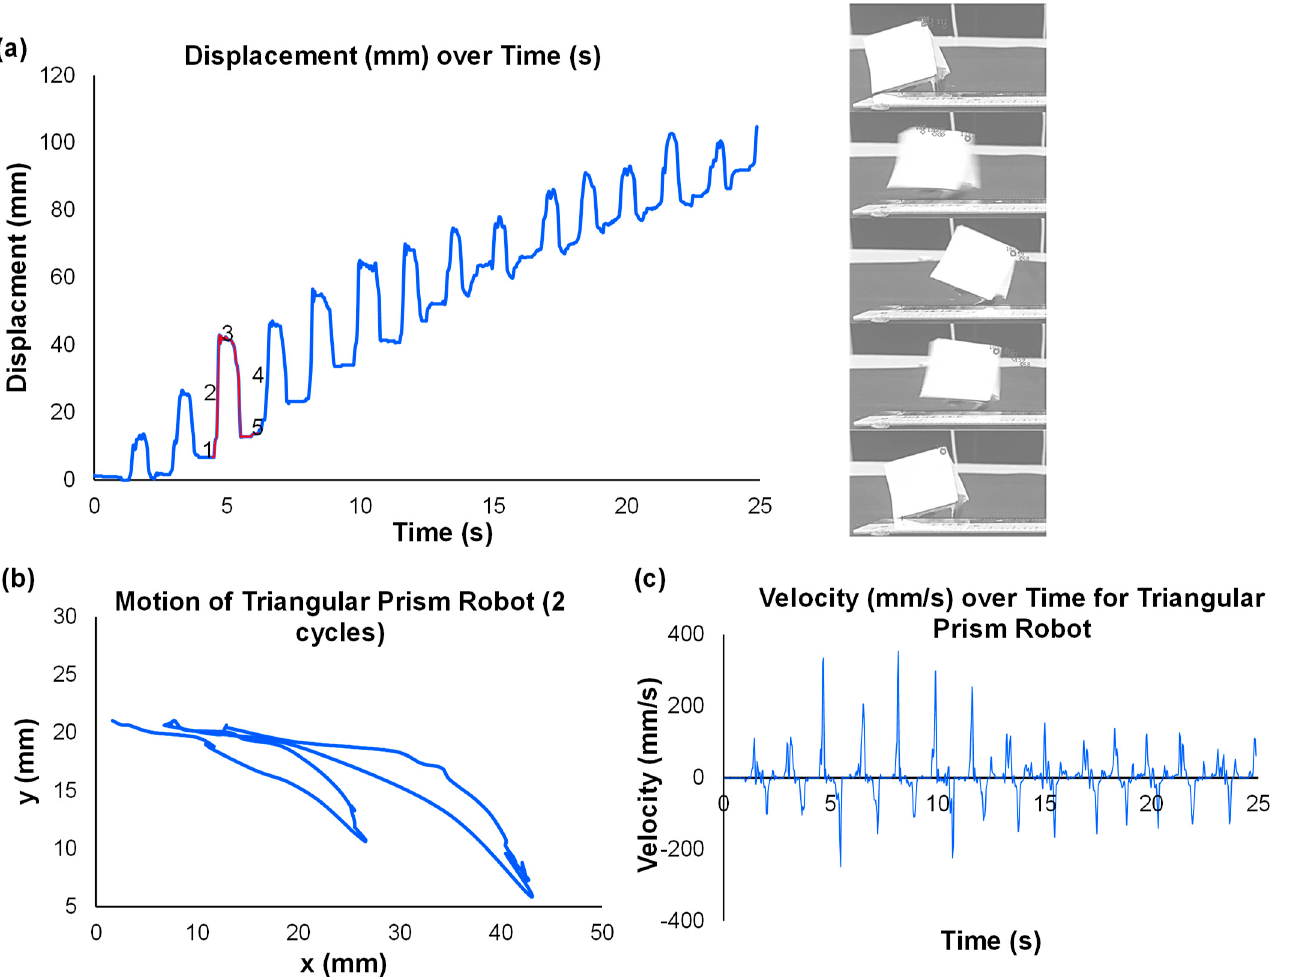
Figure 10. Locomotion of triangular prism. ( a ) Graph of displacement ( x -direction) versus time for one triangular prism mechanism prototype with out-of-plane magnetization and opposite direction magnet placement, actuated at 0.6 Hz, completing 15 cm in 35 s with 22 gait cycles. Movement of one cycle, represented by the purple section of part ( a ). ( b ) y vs. × coordinates for two cycles of motion of the triangular prism mechanism. ( c ) Graph of velocity ( x -direction) (mm/s) versus time (s) of the same triangular prism mechanism.